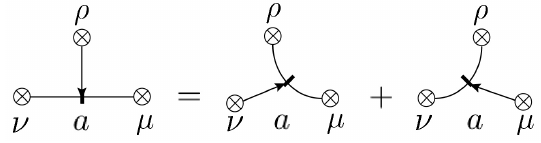
2 k ρ = F µρ 2 k ν + F ρν 2 k µ , which can be a a a a a a